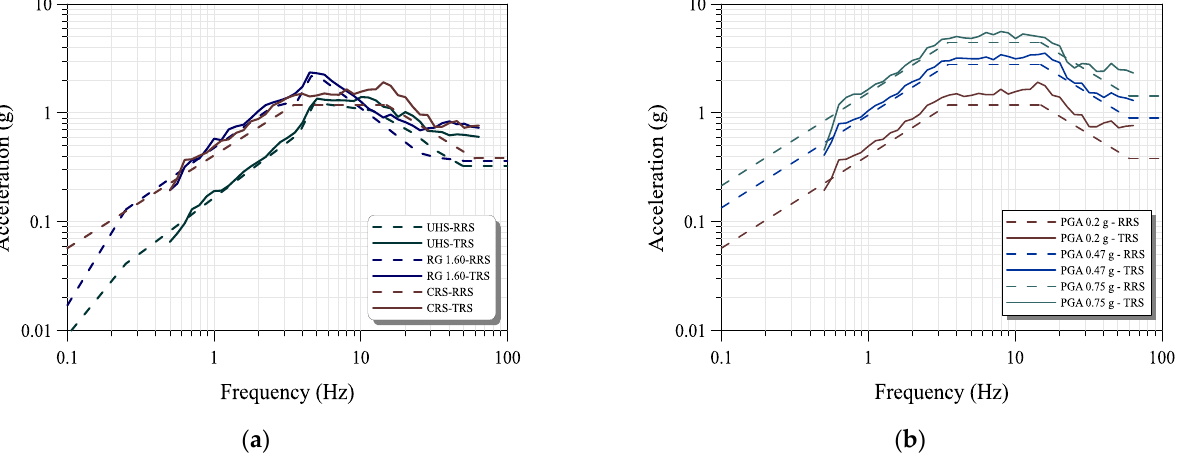
Figure 8. Acceleration response spectrum of side-to-side seismic test: ( a ) SSE level and ( b ) acceleration response spectrum depending on PGA level.